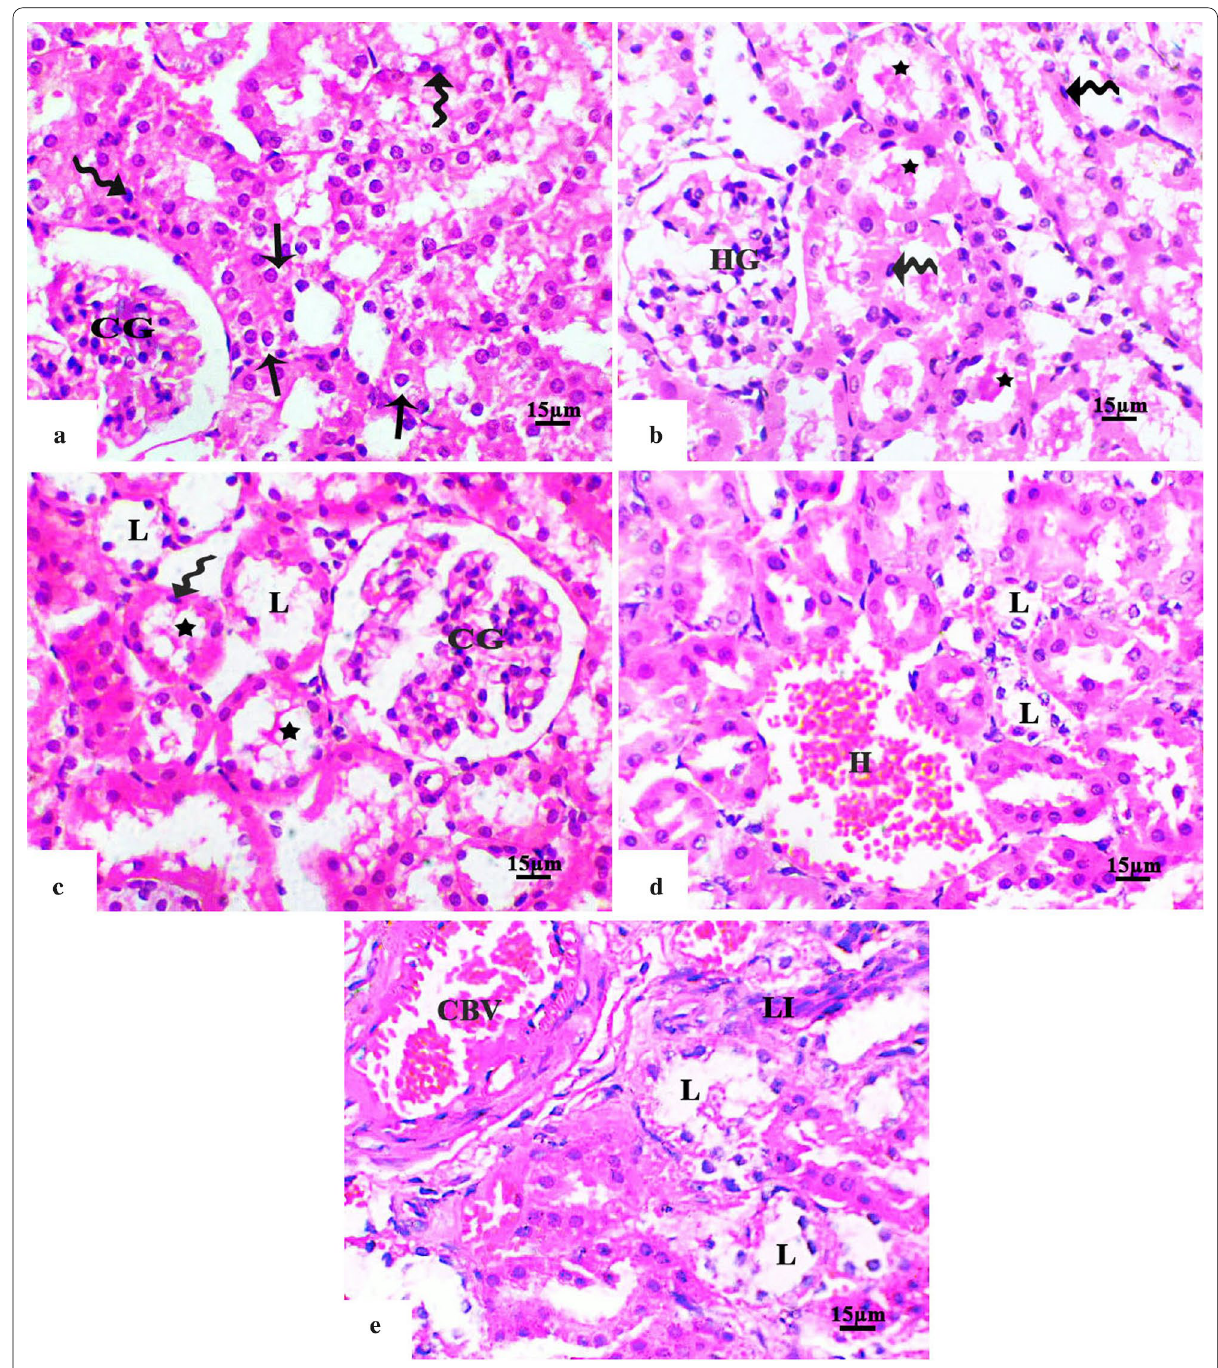
Fig. 2 Photomicrographs obtained from kidney sections of sofo-treated rats showing a – c collapsed glomerulus (CG) with widen urinary space, hypertrophied glomerulus (HG) with narrow urinary space, tubular epithelial cells with vacuolated cytoplasm (arrows), pyknotic nuclei (irregular arrows) and degenerated tubules with widen lumens (L) contain proteinaceous casts (stars), d and e widen lumens (L) of degenerated tubules, hemorrhage (H), leukocytic infiltration (LI) and congested blood vessel (CBV), (H&E, X